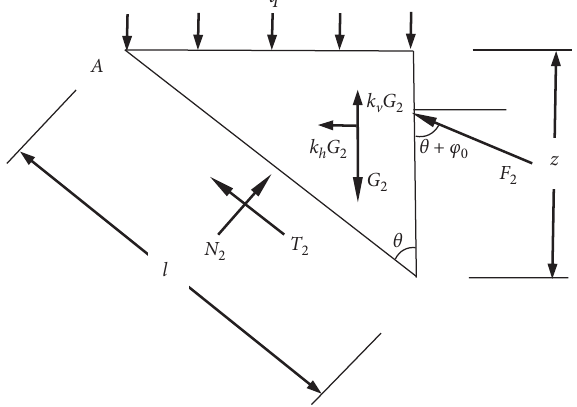
Figure 4: Force analysis of the side wall fractured zone.